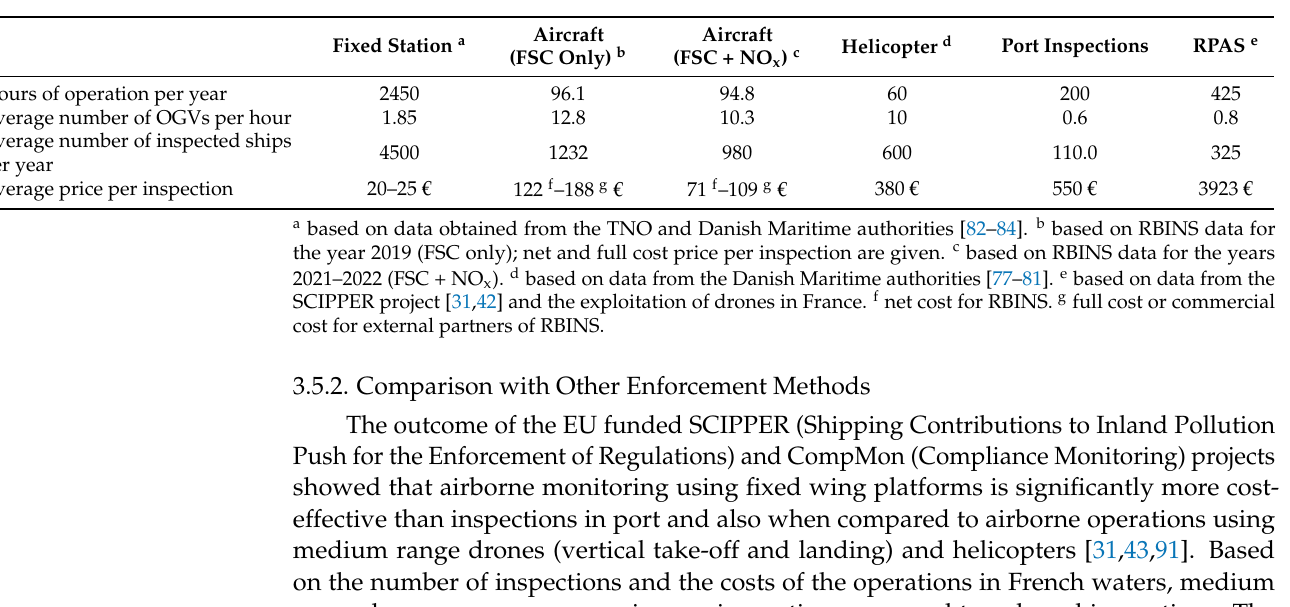
Table 4. Cost efficiency calculation for different remote measurement